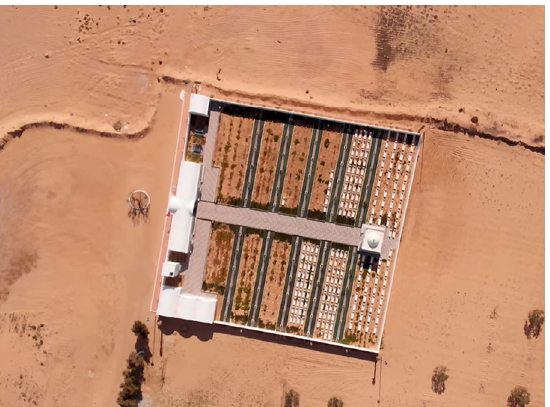
Figure 14. Le Jardin d’Afrique , Zarzis, Tunisia. 2021. Screenshot from the film about the shortlisted projects for the Aga Khan Award for Architecture 2022, Aga Khan Development Network (Aga Khan Development Network (AKDN) 2022). © Rachid